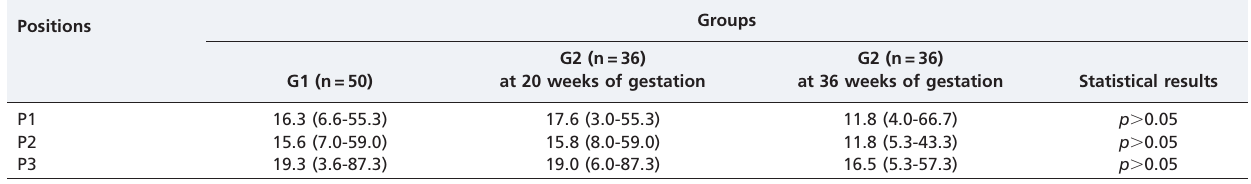
Table 3 - Maximum amplitude of PFM contraction (cmH 2 O) (median and range) in the nulliparous compared to the primiparous group at 20 weeks and 36 weeks of gestation measured using a perineometer in different positions: supine with the lower limbs straight (P1), supine with the lower limbs bent (P2), and sitting (P3). Positions Groups G2 (n=36) G2 (n=36) at 20 weeks of gestation at 36 weeks of